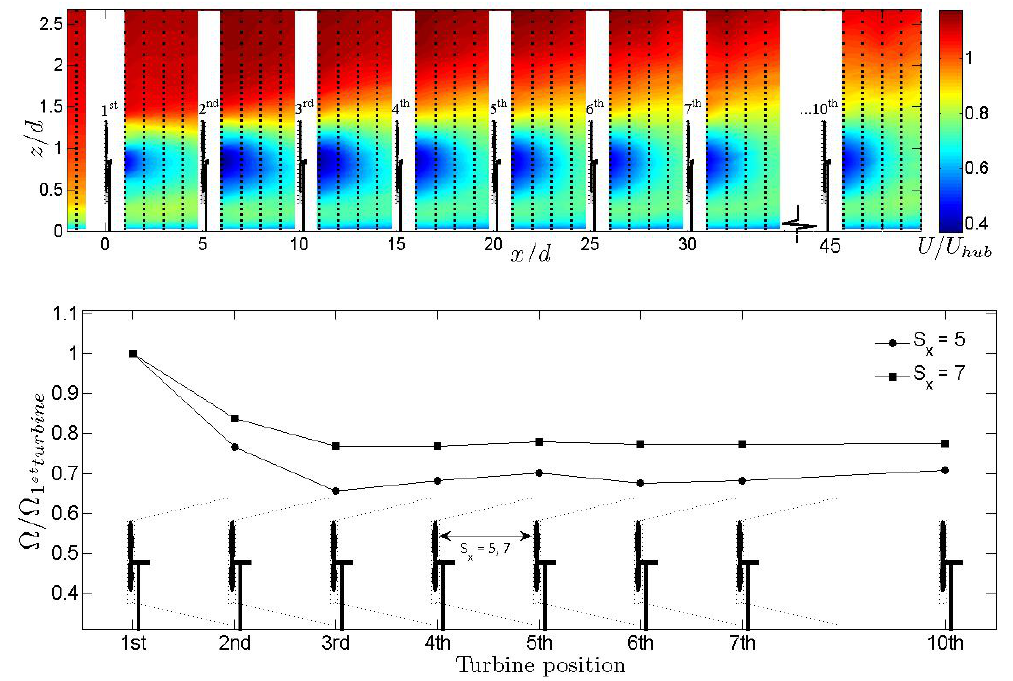
Figure 2. Non-dimensional distribution of mean velocity around the wind farm with S ( top ) and normalized angular velocity distribution of the different wind turbines with S = 7 ( bottom ). Dots indicate measurement and S x